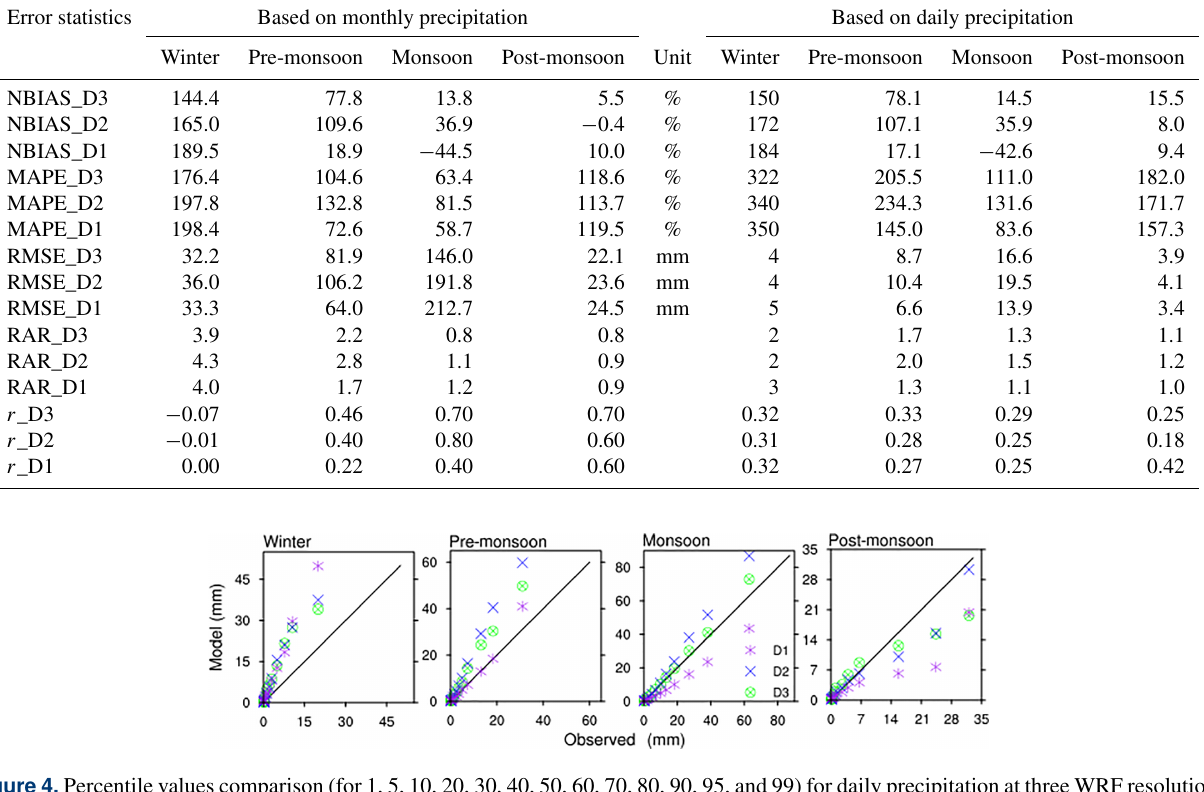
Figure 4. Percentile values comparison (for 1, 5, 10, 20, 30, 40, 50, 60, 70, 80, 90, 95, and 99) for daily precipitation at three WRF resolutions with observation for four seasons. (Percentiles calculated for precipitation > = 0.2mmday − 1 ; therefore, this has resulted in a relatively higher value in other seasons too despite lower total precipitation).